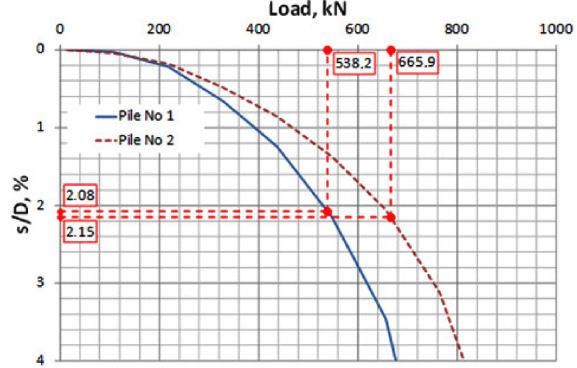
Fig. 4. Yield resistance R y and s y / D from the static load